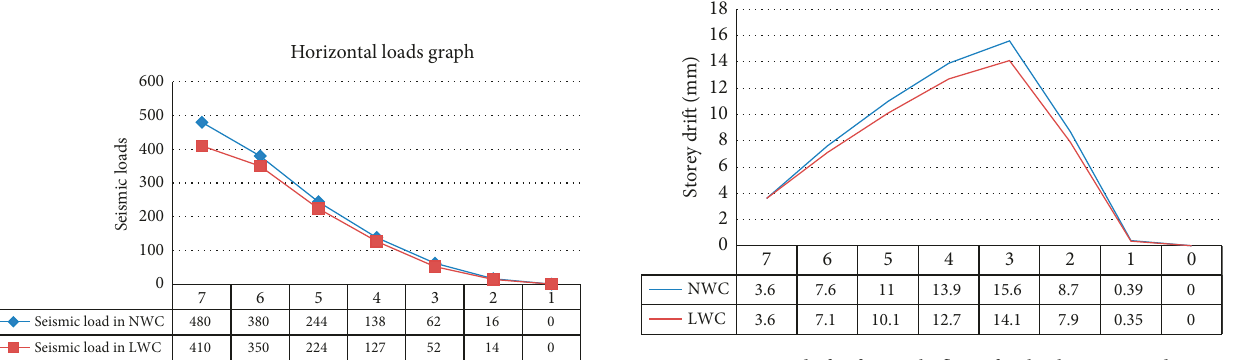
Figure 5: Horizontal loads of NWC and LWC for each floor.